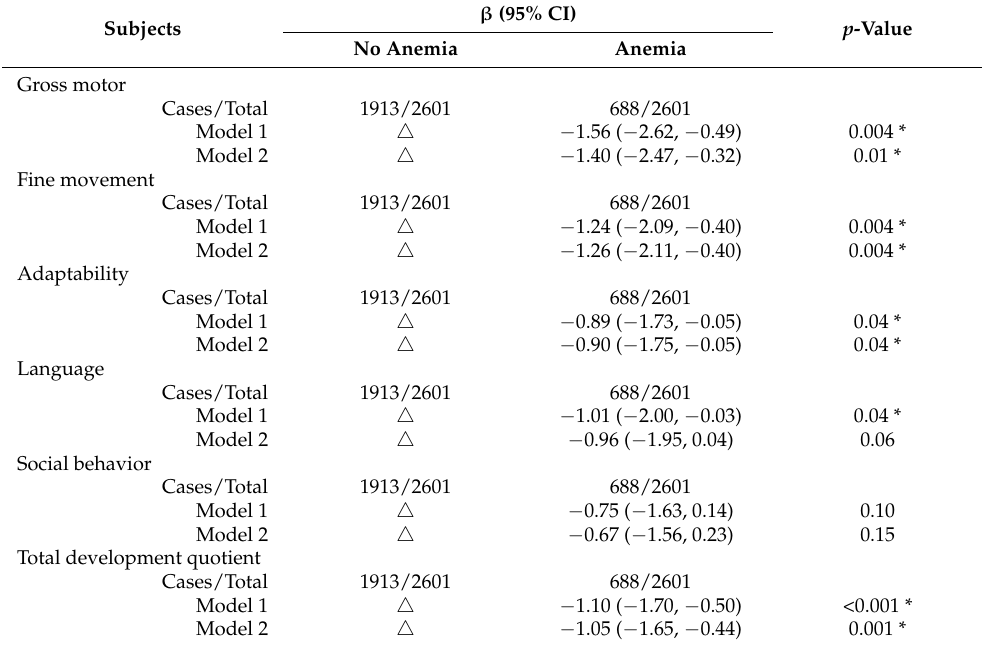
Table 3. Multiple linear regression analysis of effect of anemia on neurobehavioral development of children aged 6–24 months.